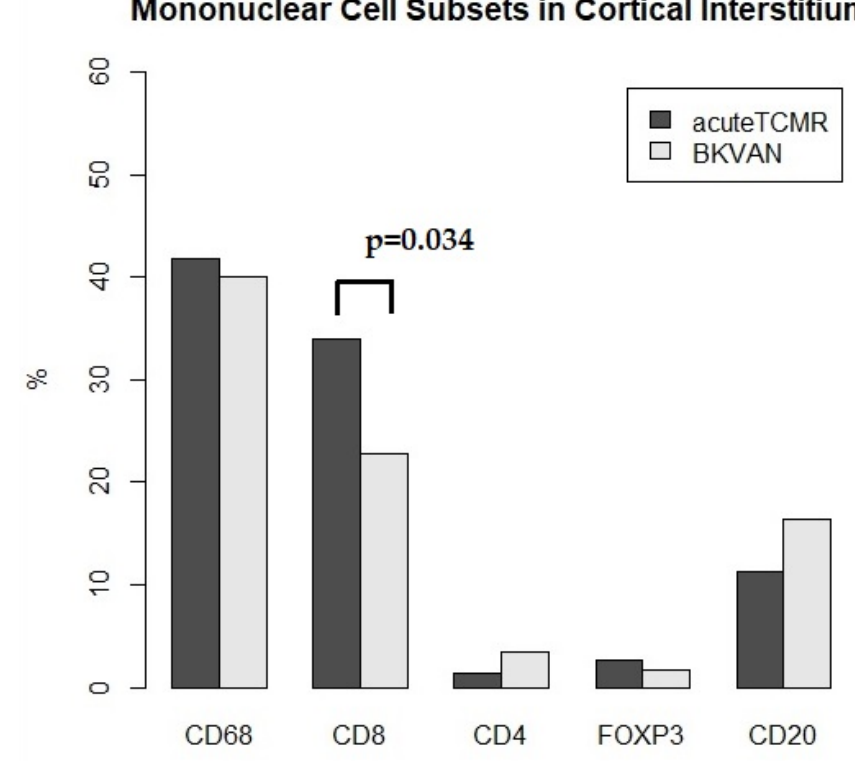
Figure 4. The proportions of mononuclear cell subsets for acute TCMR versus BKVAN cases in cortical interstitium. CD8+ cells were significantly more prevalent in TCMR than BKVAN cases ( p =